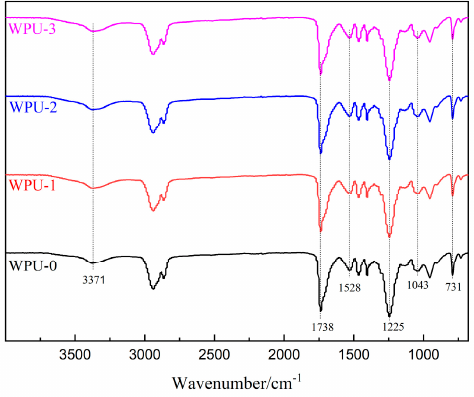
Figure 2. Infrared spectra of di ff erent WPU.